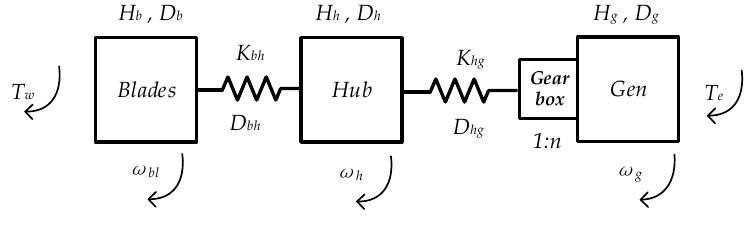
Figure 2. Mass-spring model of the turbine generator system.